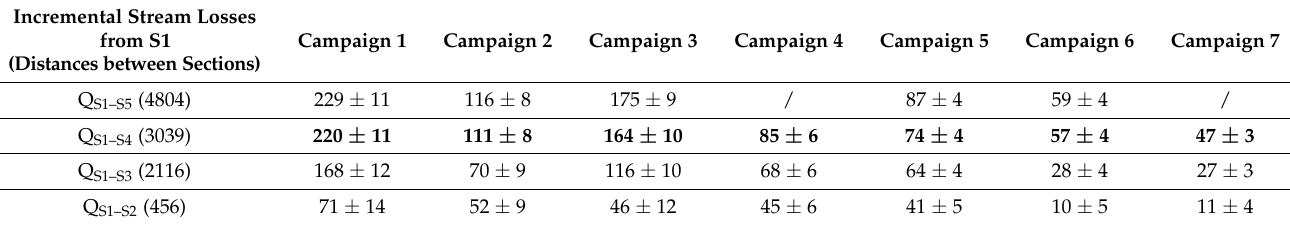
Table 4. Losses from streambed (in ls − 1 along with the corresponding uncertainties calculated with the error propagation method presented by [33]). Values used as y -axis (i.e., total stream losses) for obtaining regression line in Figure 5 are highlighted in